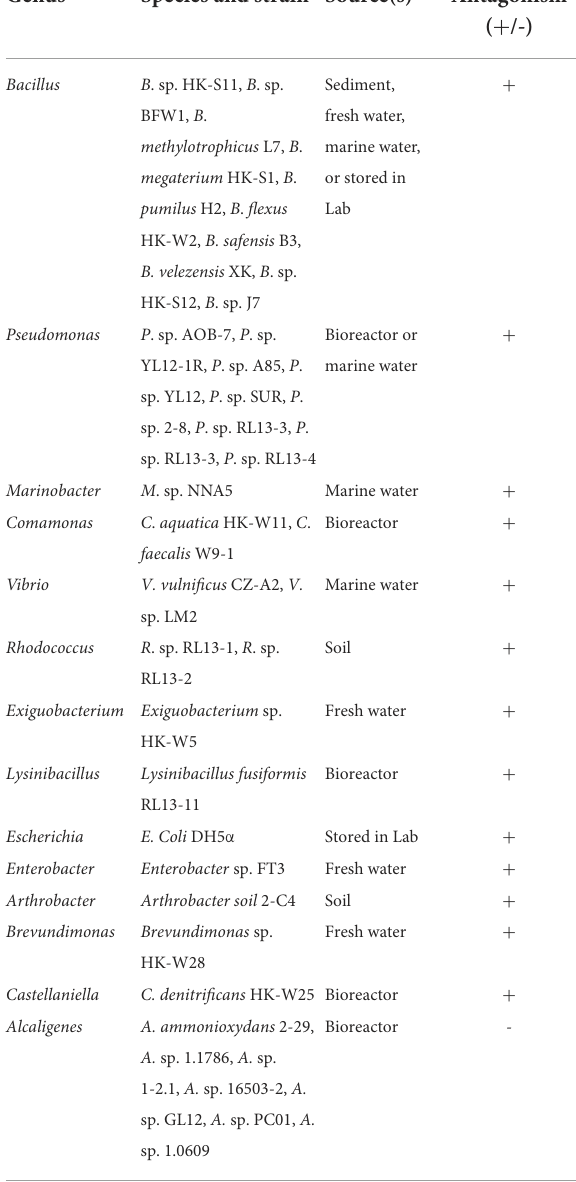
TABLE 1 Antagonistic effect of A. ammonioxydans HO-1 against 40 environmental bacterial isolates. Genus Species and strain